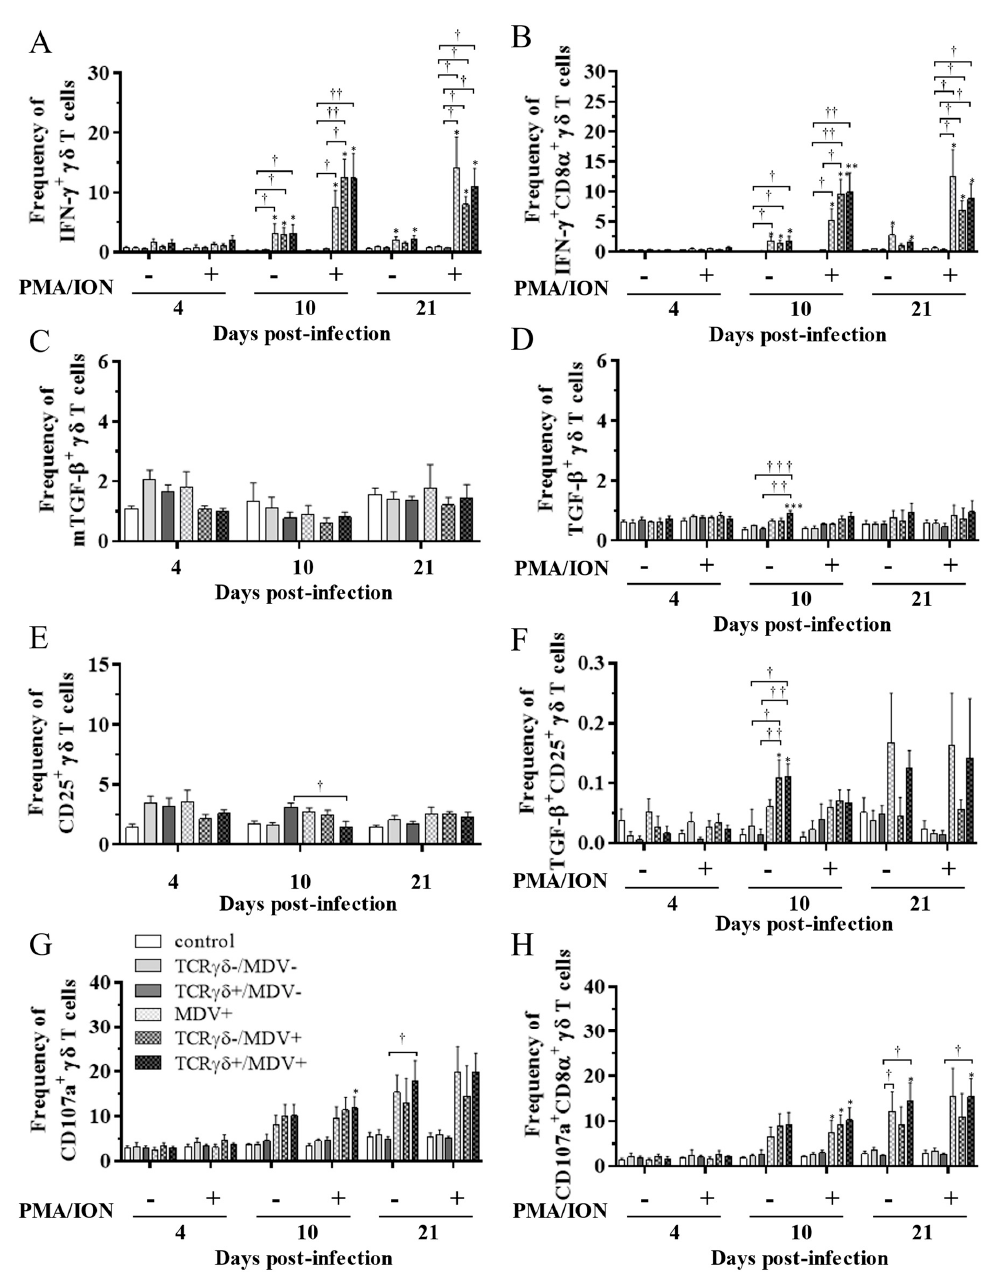
Figure 8. Cytokine and immune system molecule profiles in γδ T cells derived from the PBMCs at 4, 10, and 21 dpi. The PBMCs obtained from the control, the unstimulated PBMCs control, the TCR γδ -/MDV-, the TCR γδ +/MDV-, the MDV+, the TCR γδ -/MDV+, and the TCR γδ +/MDV+ groups were cultured with and without PMA/ION for 4 h. Percentages of IFN- γ + γδ T cells ( A ), IFN- γ +CD8 α + γδ T cells ( B ), mTGF- β γδ T cells ( C ), TGF- β γδ T cells ( D ), CD25+ γδ T cells ( E ), TGF- β +CD25+ γδ T cells ( F ), CD107a+ γδ T cells ( G ), and CD107a+CD8 α + γδ T cells ( H ) within γδ T cell populations in the PBMCs collected from each group at 4, 10, and 21 dpi are shown. Data represent the mean of 5 biological replicates ± SE in each group at each time point. Significant differences are indicated by *: p < 0.05 (vs. control), **: p < 0.01 (vs. control), ***: p < 0.001 (vs. control), †: p < 0.05, ††: p < 0.01, and †††: p < 0.001.